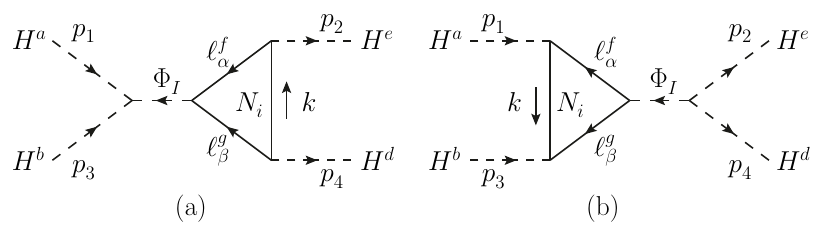
Figure 1 . The 1LPI diagrams with external lines generated by the (cid:0) H † H † HH (cid:1) field configuration in the type-(I+II) seesaw